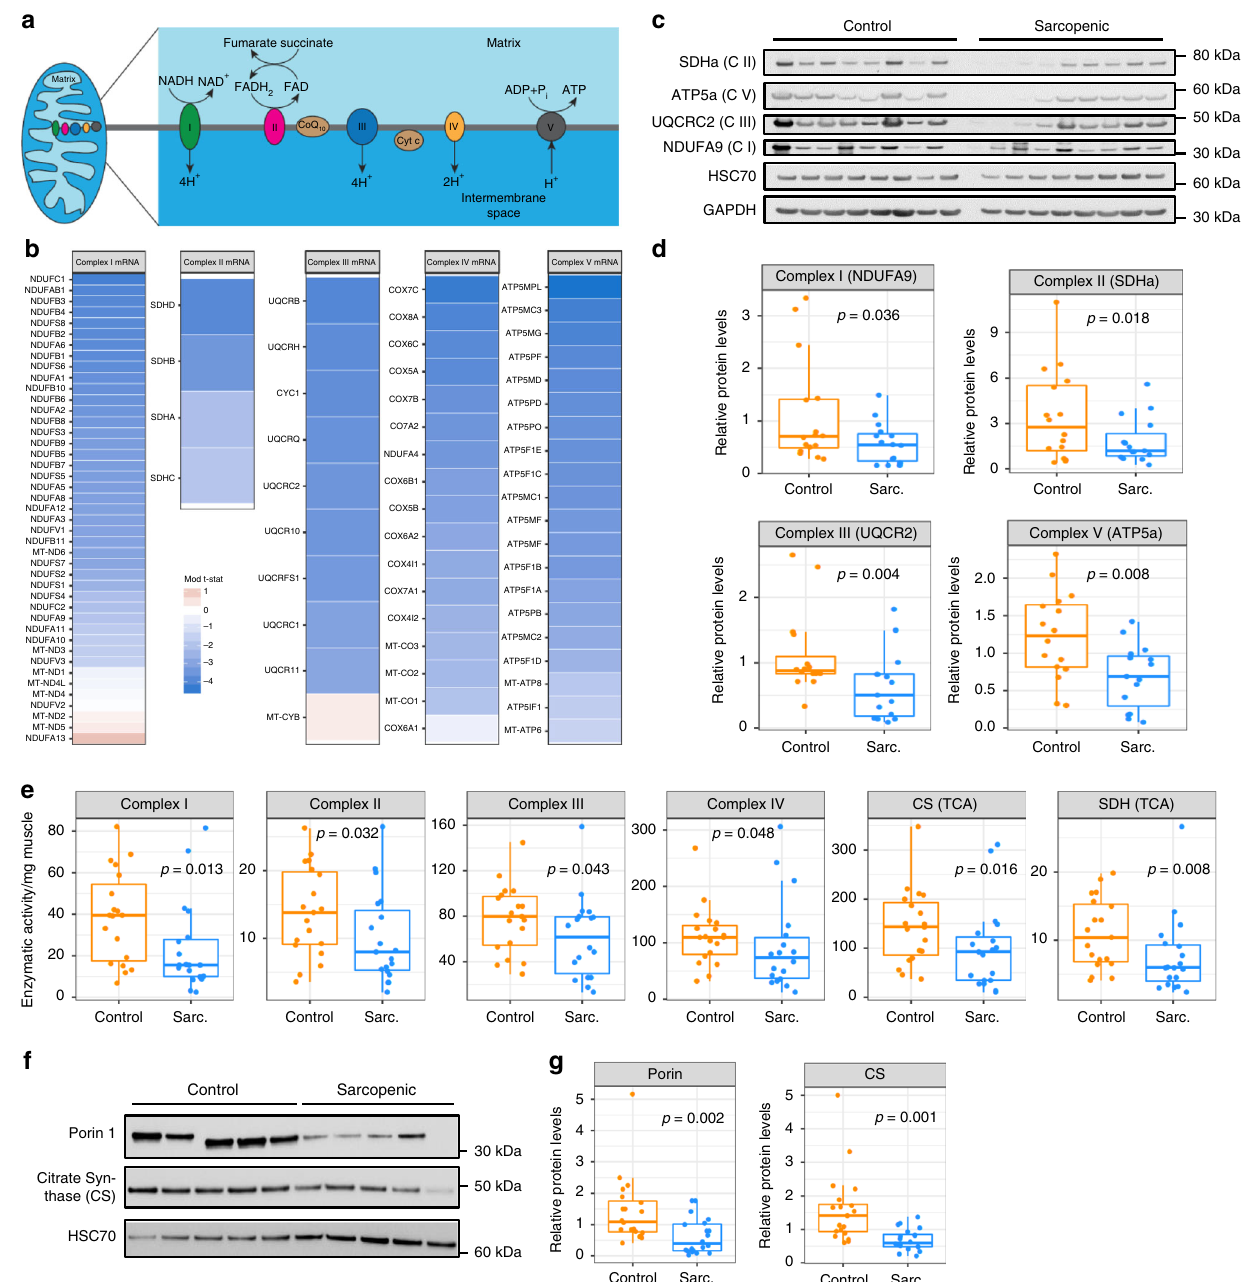
Fig. 5 Mitochondrial bioenergetic activity is decreased in sarcopenic muscle. a Schematic representation of a mitochondrion and the fi ve respiratory complexes of the electron transport chain. b Gene expression change in sarcopenic vs. control muscle of mRNAs encoding the subunits of the 5 mitochondrial respiratory chain complexes, color coded according to moderated t-statistics (SSS cohort; n = 19 – 20 per group). c , d Muscle protein expression of representative subunits of mitochondrial respiratory chain complexes and mitochondrial proteins measured by western blot. c Representative blots from one gel, with GAPDH and HSC70 included as house-keeping normalization controls. d Quanti fi cation of protein levels relative to GAPDH and HSC70 in all remaining samples analyzed (SSS cohort; n = 15 – 16 per group; p values calculated using Mann – Whitney tests). e Enzymatic activity per mg muscle tissue of mitochondrial complexes I – IV, citrate synthase (CS) and succinate dehydrogenase (SDH) measured on mitochondrial extracts from remaining muscle biopsies of control and sarcopenic participants (SSS cohort; n = 18 per group; p values calculated with Mann – Whitney tests). f , g Muscle protein expression of porin 1 and CS measured by western blot on remaining muscle samples of the SSS cohort ( n = 20 per group; p values calculated with Mann – Whitney